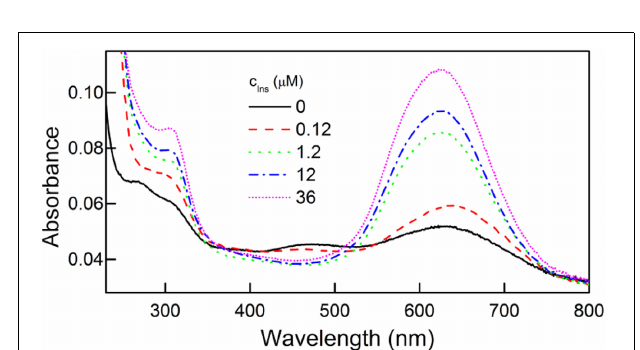
FIGURE 3 | UV spectra of DR/Pec films irradiated in the absence and in the presence of different concentrations of insulin and then immersed in 0.01% w/v CBBG solution for 24h.